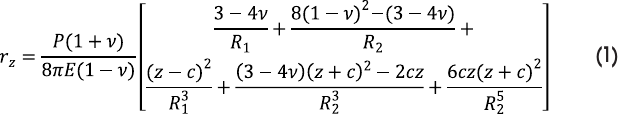
centrada vertical aplicada em um ponto desse meio. A Figura 5 apresenta as variáveis envolvidas no problema.